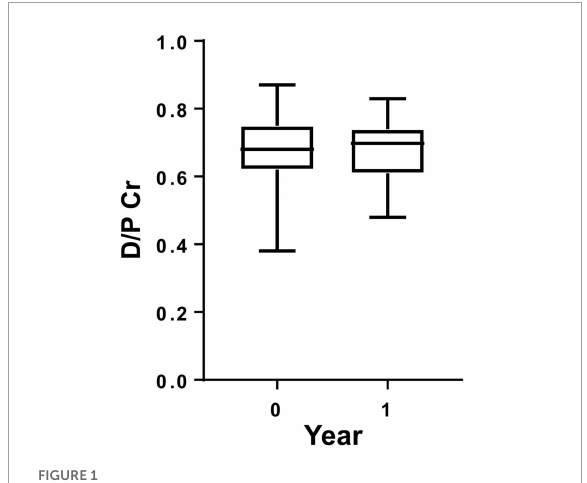
FIGURE1 Dialysate-to-plasma creatinine ratio (D/P Cr) in patients on peritoneal dialysis. D/P Cr did not show any significant change during 1 year of